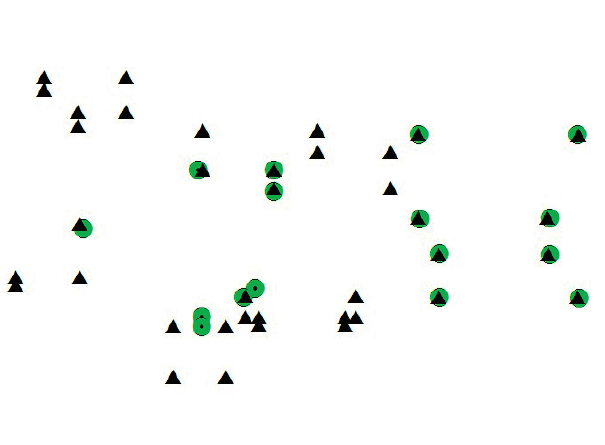
Figure 2. Initial matching results of airborne corners (black triangles) and terrestrial corners (green